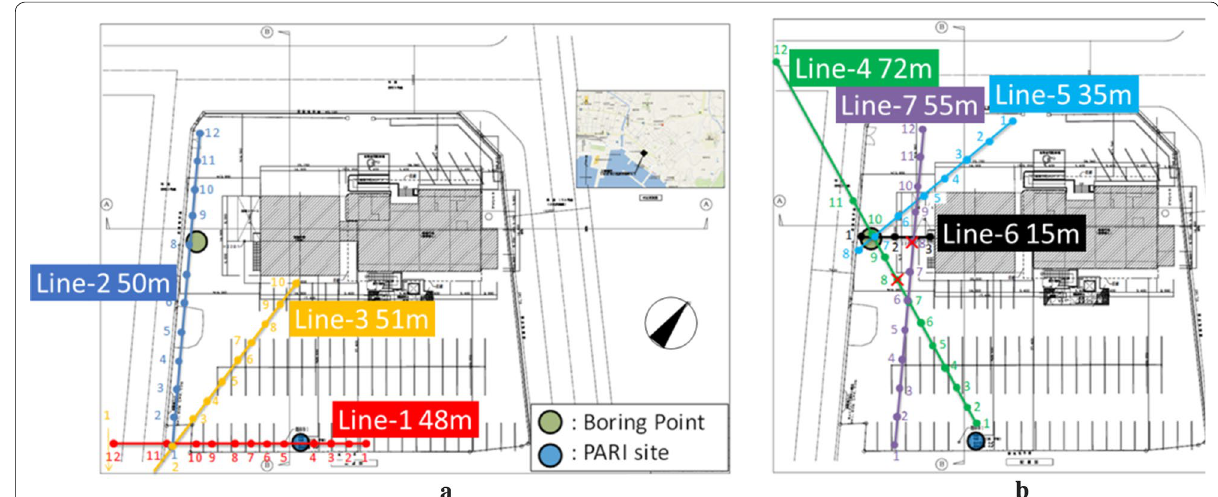
Fig. 2 The microtremor observation points within the premises of the Onahama Port Office for a Line-1 to Line-3 and b Line-4 to Line-7. The blue and green circles denote the strong motion observation site and the boring point by the PRENOLIN Project (Régnier et al. 2015), respectively